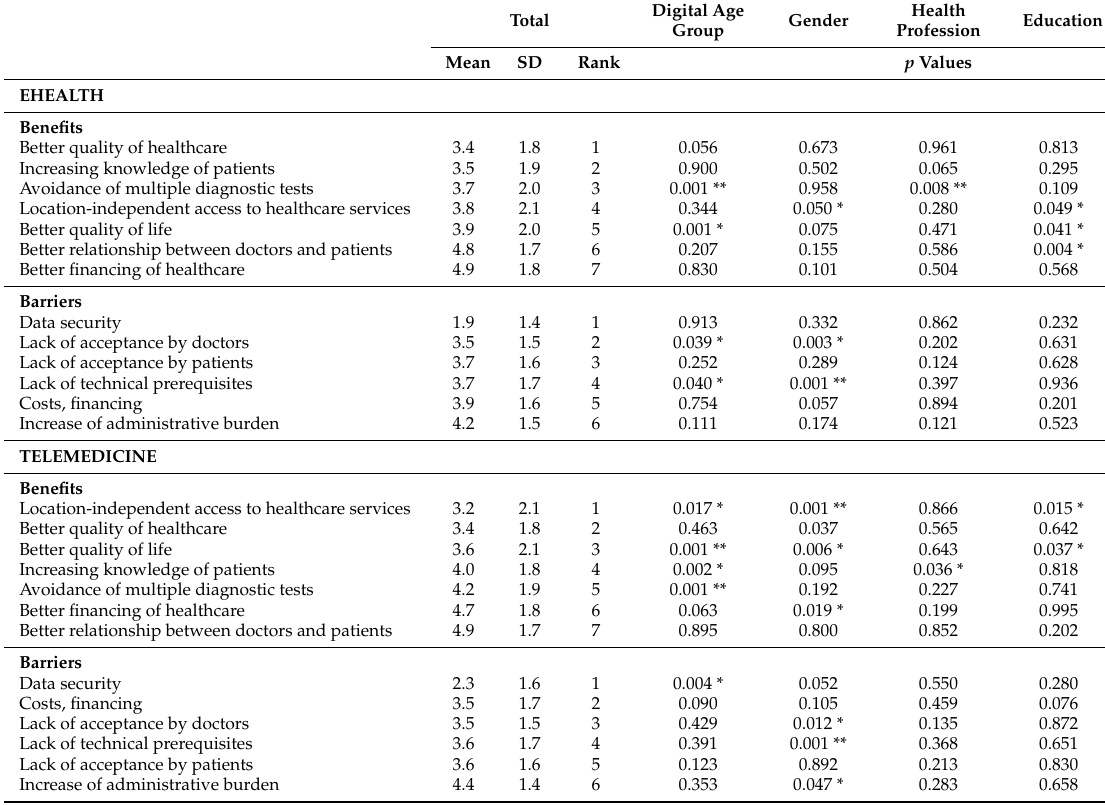
Table 4. Ranking of benefits and barriers of eHealth and telemedicine, ordered by total rank. Total Digital Age Group Gender Health Profession Education Mean SD Rank p Values